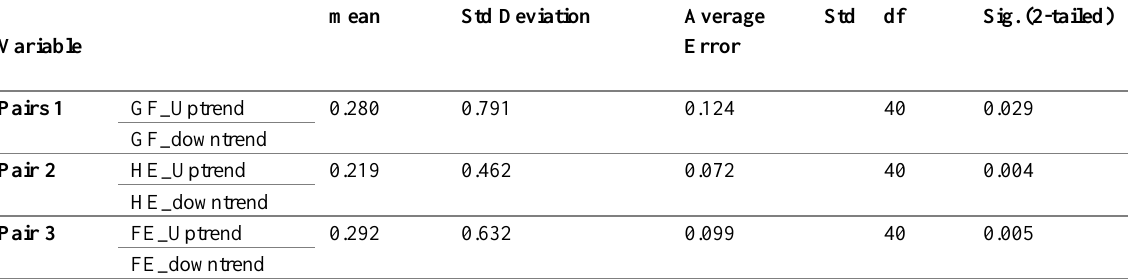
Table 3: Paired T-Test between Uptrend and Downtrend